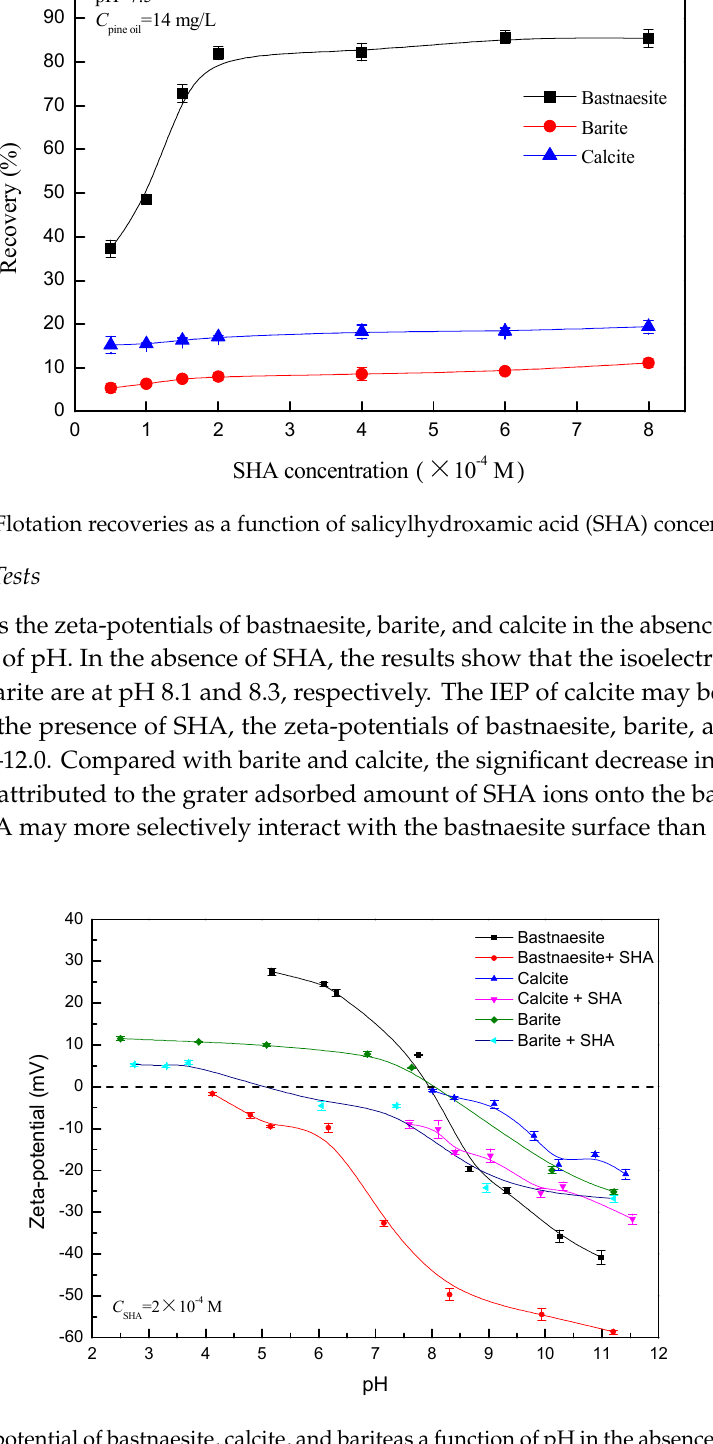
Figure 2. Flotation recoveries of the minerals as a function of pH.